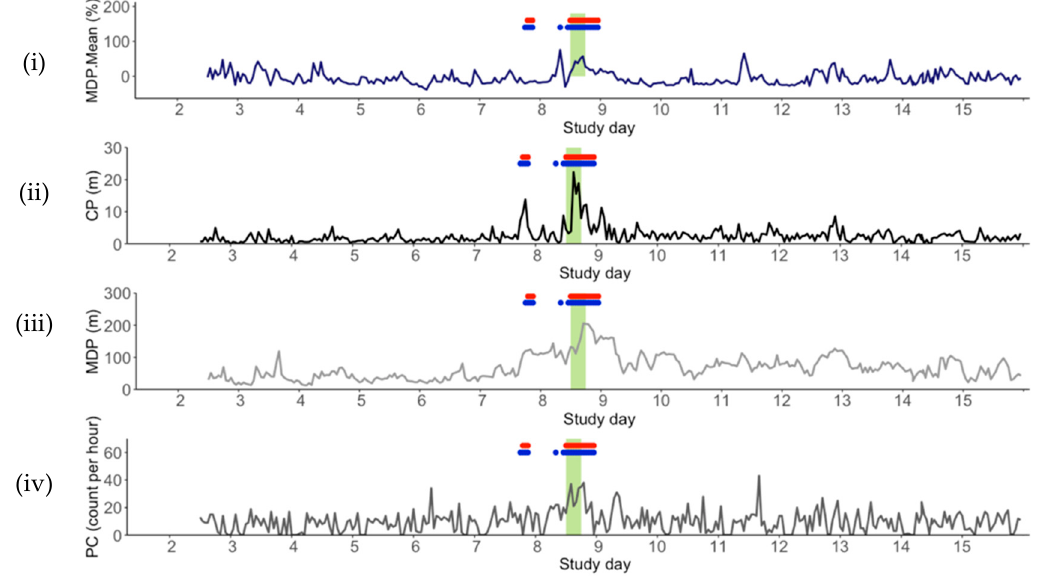
Figure 3. Individual datasets for Animal 9 ( a ); Animal 6 ( b ) and Animal 2 ( c ) (Trial Two). Features include ( i ) MDP.Mean (blue); ( ii ) CP (black); ( iii ) MDP (light grey); ( iv ) PC (dark–grey). Though the model was applied as a simulated online scenario, data is presented for all study days to enable visualisation of broader patterns. Alerts are shown for two scenarios: hour of alert (blue circles) and two consecutive ‘lamb’ hours required before alert (red circles). Alerts are included up to the day of birth for both scenarios. The hours of known lambing (Hours ± 3) are included as pale green shading.